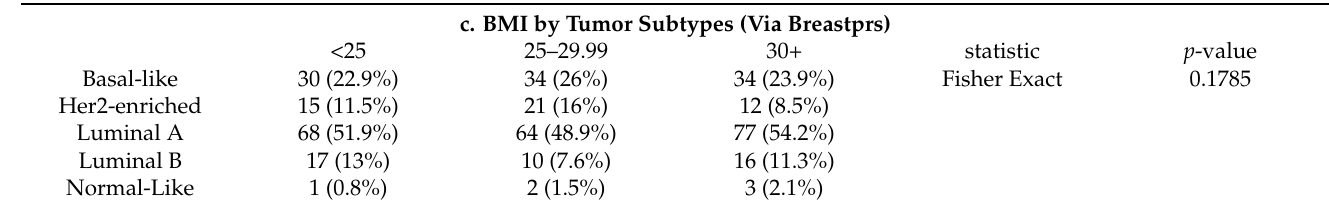
Figure 1. Boxplots of specific interferon signaling genes expressed in African ‐ American obese pa ‐ tients compared to European ‐ American obese patients under gene expression number GSE79858. ( A ) Boxplot of IFNG expression in obese African ‐ Americans (AAOB) compared to obese European ‐ Americans (EAOB). ( B ) Boxplot of STAT1 expression in AAOB vs. EAOB. ( C ) Boxplot of IL10 ex ‐ pression in AAOB vs. EAOB. ( D ) Boxplot of IL6R in AAOB vs. EAOB. Table 4. Immunomodulators significantly upregulated in basal ‐ like obese breast cancer patients compared to other